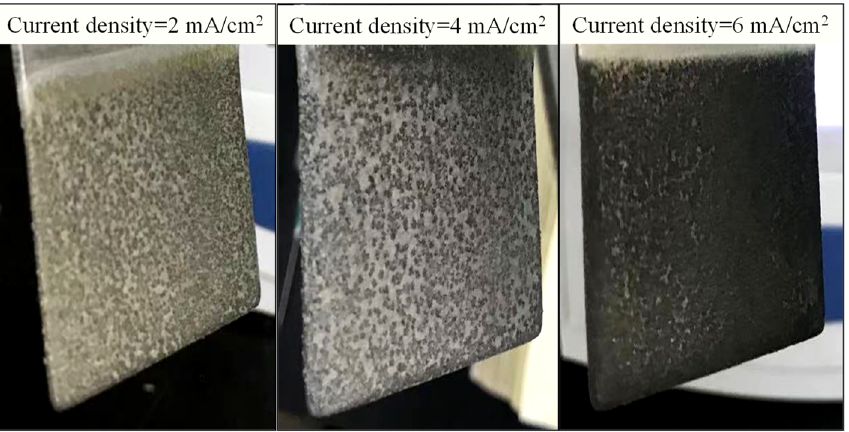
Figure 4. Visual observation of Mg anode at various current densities and the same pH of 7.0.